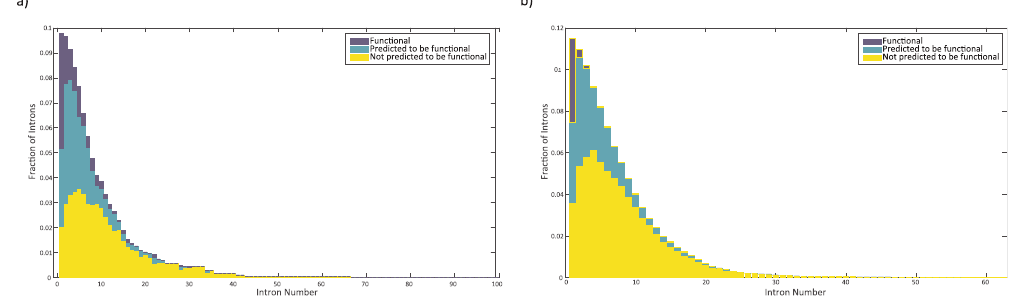
Figure 6. Distribution of functional introns (known or predicted) by intron number on (a) Dataset 1 and (b) Dataset 2. Blue: known functional introns, turquoise: introns predicted to be functional, yellow: introns predicted to be